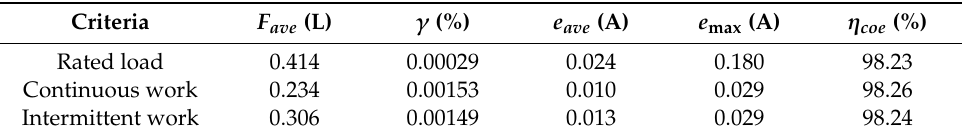
Table 3. Evaluation